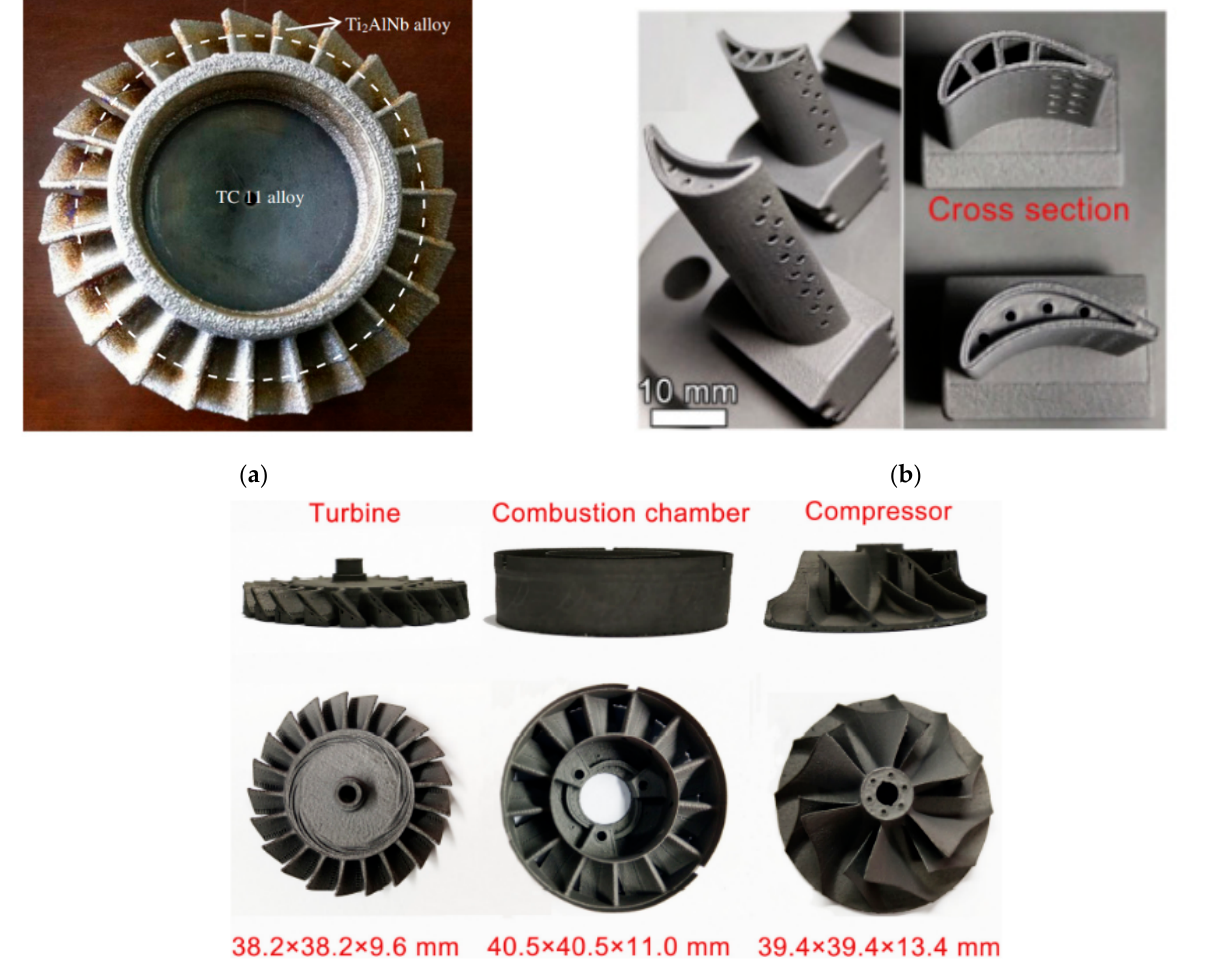
Figure 10. Prototypes of MAM parts of O-phase alloys. Reproduced with permission from Elsevier [62] ( a ), [11] ( b ), [70] ( c ).